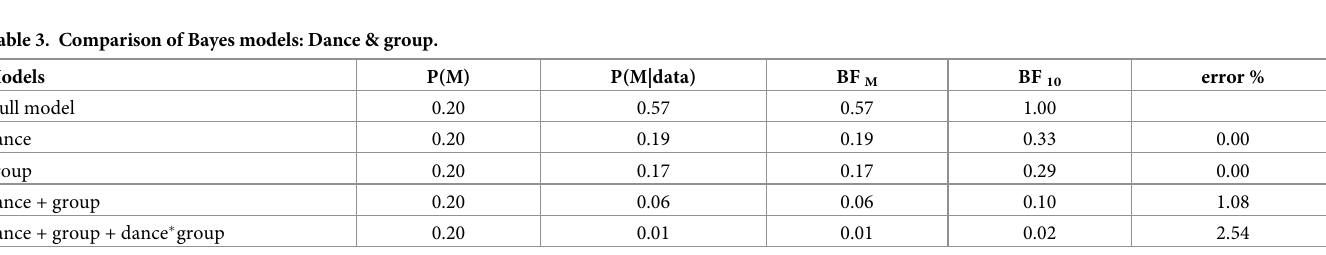
Table 3. Comparison of Bayes models: Dance & group.